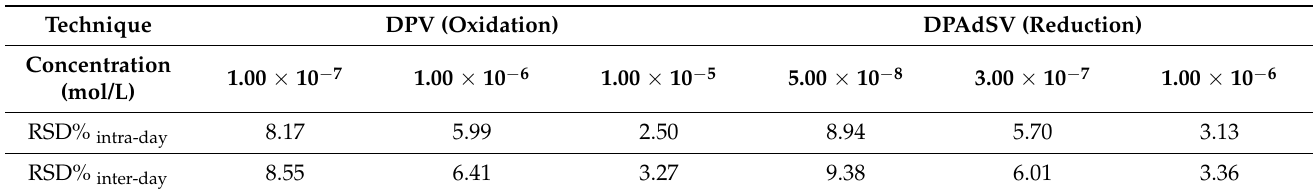
Table 4. Results obtained in precision study for the voltammetric determination of different concentration levels of HESP in BRB pH 1.81 solutions at H type